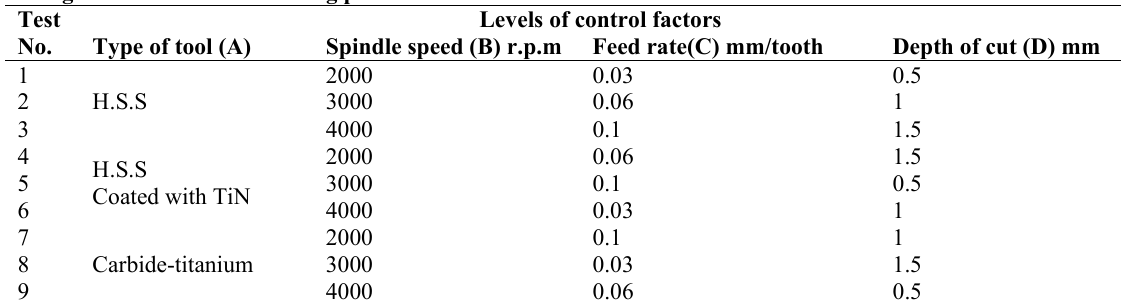
Table 5, Cutting tools and machine cutting parameters.